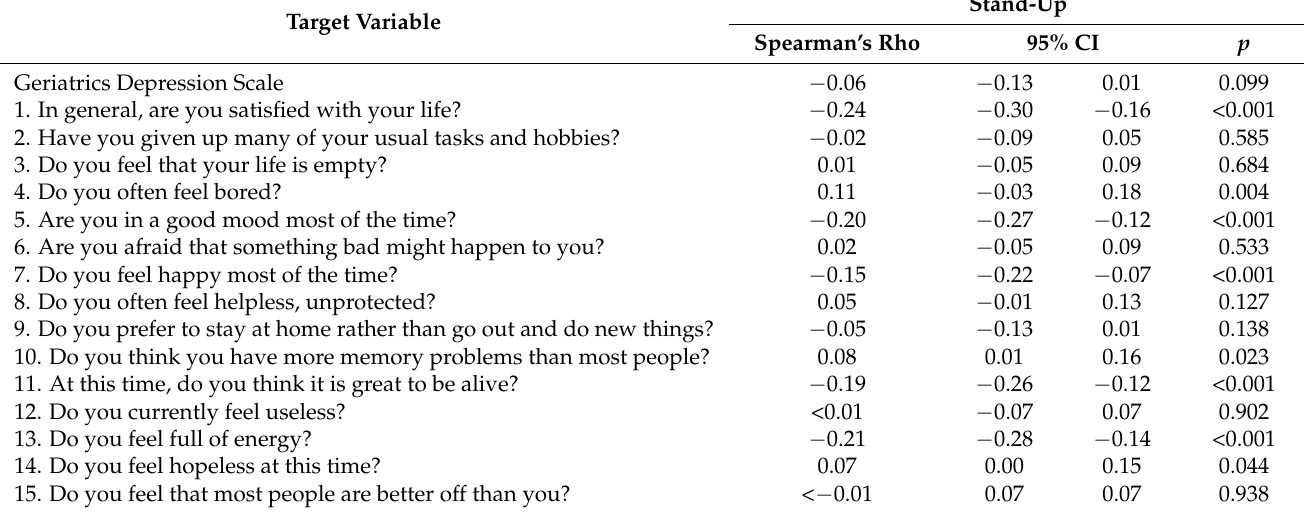
Table 2. Correlation between stand-up test and GDS in older women with